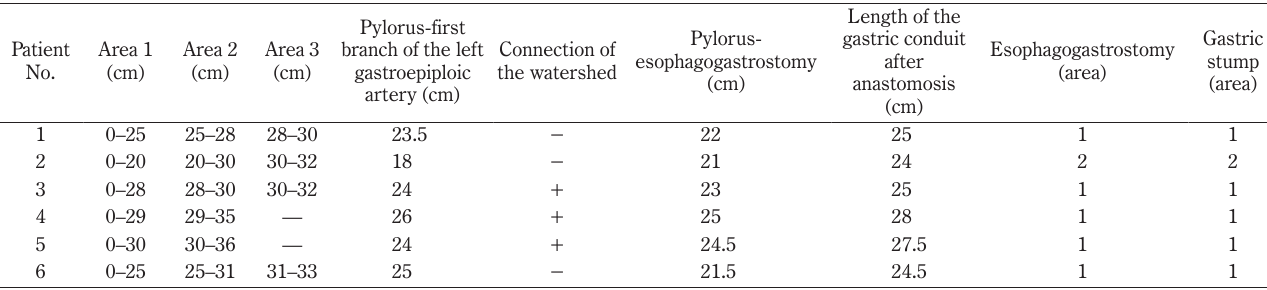
Table 5 Indocyanine green fluorescence in the 3-cm-wide greater curvature gastric conduit Patient